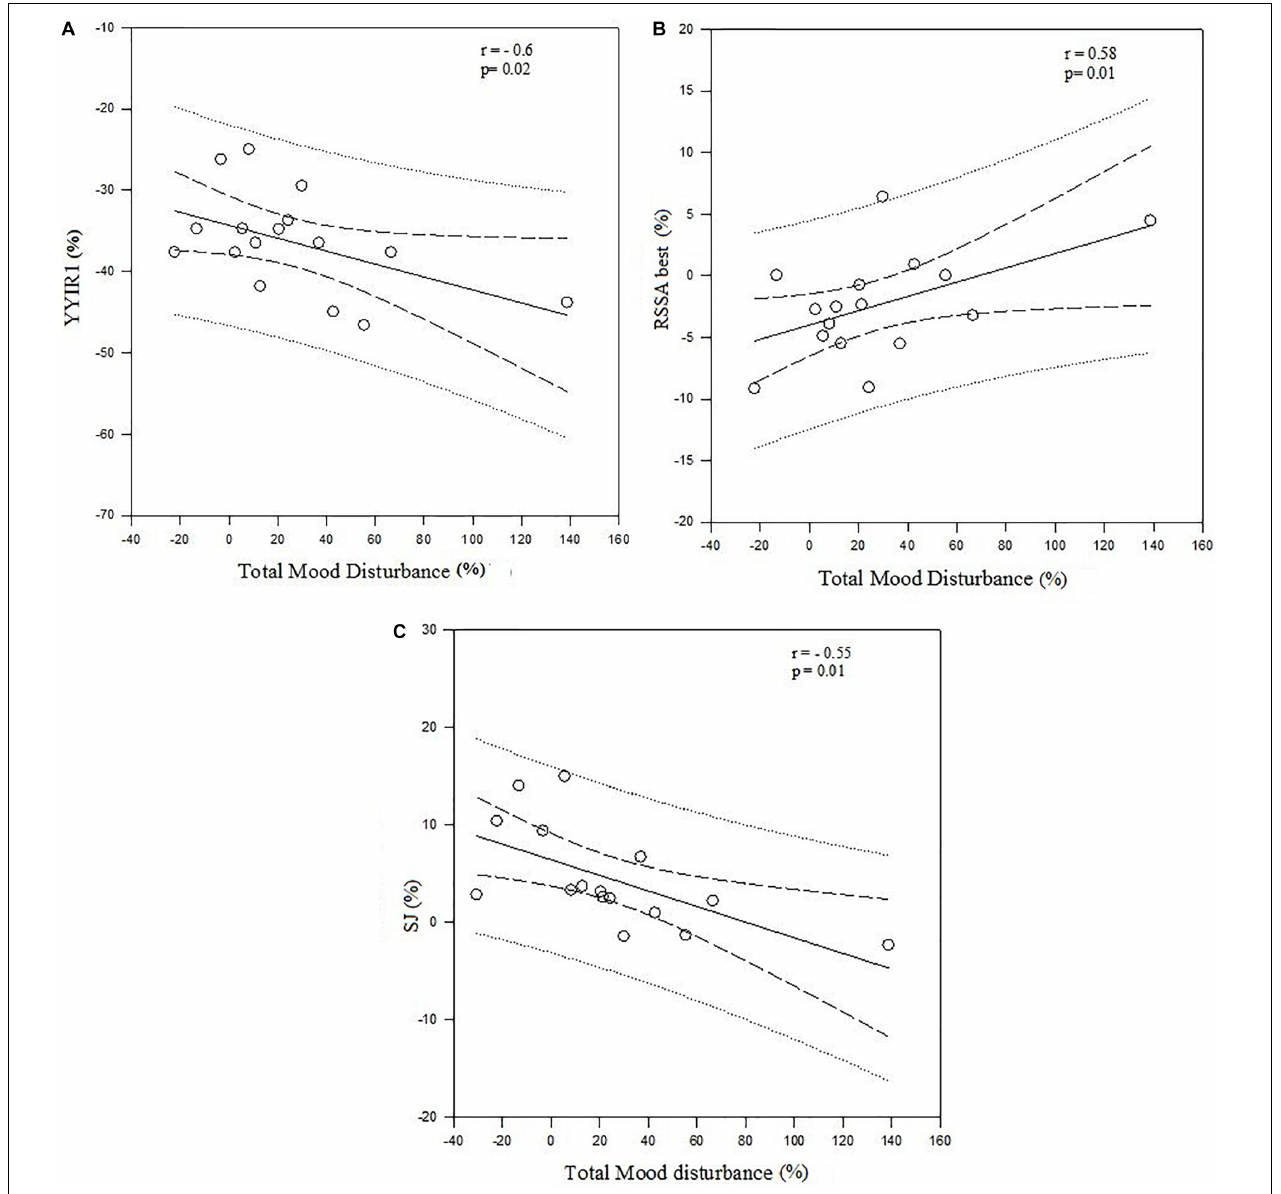
FIGURE 2 | (A) Correlation between (cid:49) % Total Mood Disturbance and (cid:49) %YYIR1 during the congested period of match play. YYIR1: Yo-Yo Intermittent Recovery test level 1. (B) Correlation between (cid:49) % total mood disturbance and RSSAbest during the congested period of match play. RSSA: Repeated Shuttle Sprint Ability test. (C) Correlation between (cid:49) % total mood disturbance and SJ during the congested period of match play. SJ: Squat